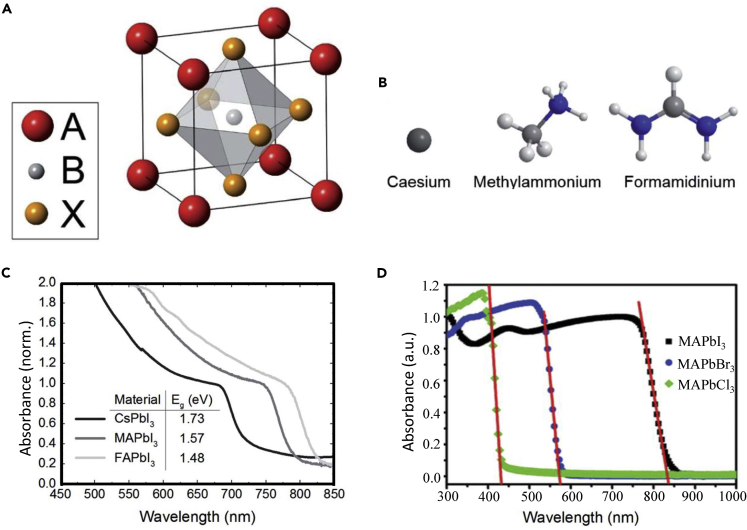
Perovskite Crystal Structure and Band-gaps(A) The ABX3 perovskite crystal structure.(B) The atomic structure of the three A site cations including Cs, MA, and FA.(C and D) (C) UV-vis spectra of the APbI3 perovskites, where A is Cs, MA, or FA. (D) UV-vis spectra of the MAPbX3, where X is I, Br, or Cl. (A–C) Reproduced with permission (Eperon et al., 2014). Copyright 2014, Royal Society of Chemistry. (D) Reproduced with permission (Liu et al., 2015). Copyright 2015, Wiley-VCH.